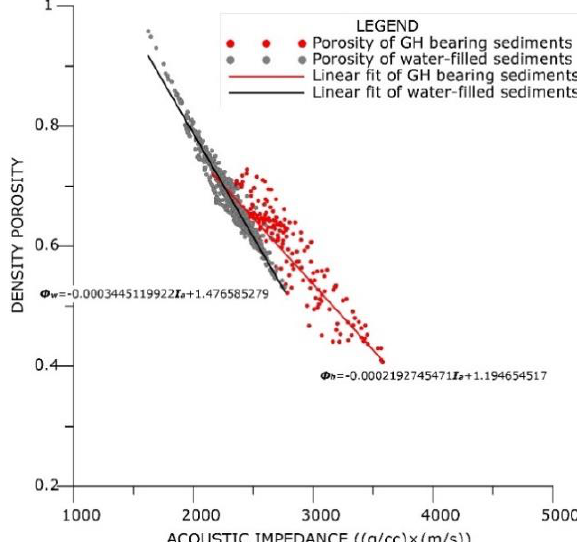
Figure 8. Plot of density porosity vs. acoustic impedance at the UBGH2-6 well. Red and grey dots indicate the porosity of GH-bearing and non-GH-bearing sediments, respectively.